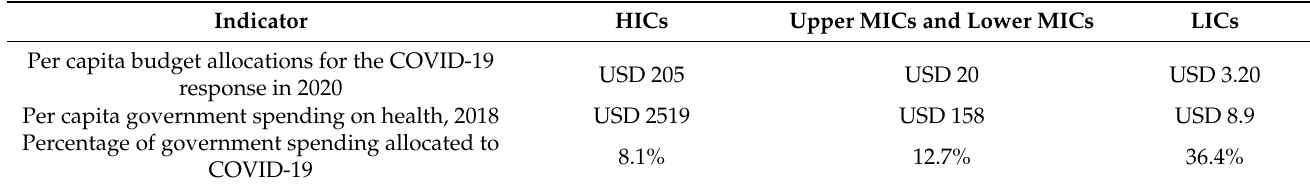
Table 3. Spending on COVID-19 as a proportion of health system budgets [14] 1